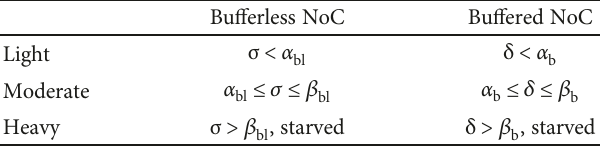
Table 1: Partition of congestion degree in hybrid NoCs.